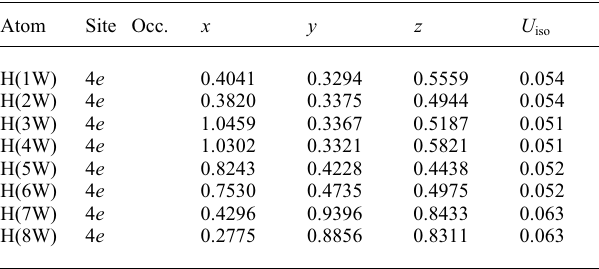
Table 2. Atomic coordinates and displacement parameters (in Å 2 )